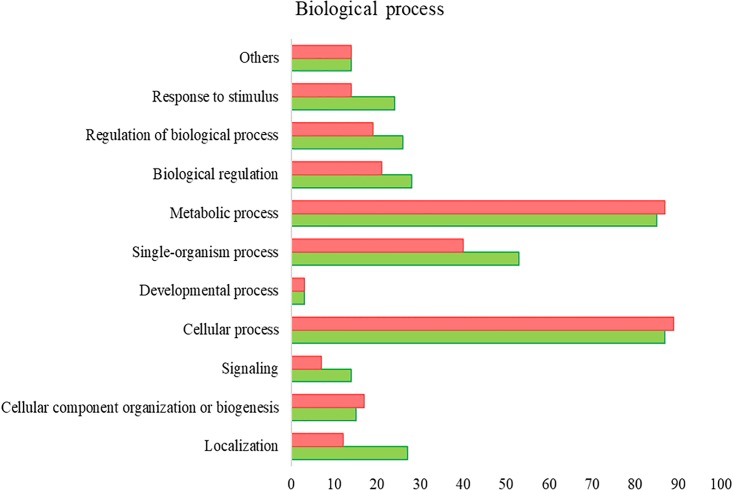
Gene ontology of the proteins from R. annulatus in response to B. bigemina infection. GO terms and its representation of BP (level 2). Green bars show over-represented proteins and red bars under-represented proteins with statistical significance (p < 0.05).